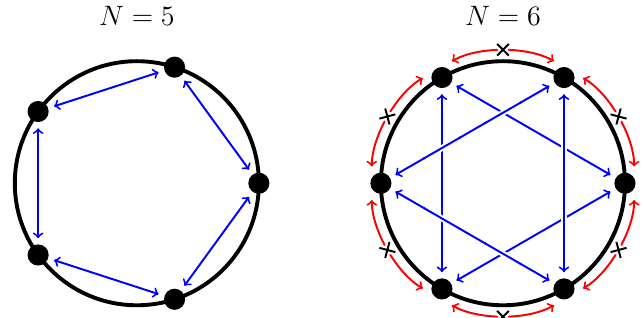
Figure 3: Examples of tunneling events between center-breaking minima on (cid:82) × S 1 with anti-periodic boundary conditions. The blue lines depict the minimal action tun- neling events without fermion zero modes. The red lines (marked with crosses) rep- resent tunneling events with robust fermion zero modes. When N = 5, the 5 − 1 = 4 zero modes found in the Abelian ansatz are all lifted in generic field configurations because ζ = 4 mod 2 = 0. As a result, the (cid:90) center symmetry is completely un- 5 broken. When N = 6, instantons associated with tunneling between neighboring minima carry ζ = 6 − 1 mod 2 = 1 robust fermion zero modes, and are forbidden. However, instantons associated with tunneling between next-to-nearest neighbors carry ζ = 2 ( 6 − 1 ) mod 2 = 0 robust zero modes, and are not forbidden. As a result, the (cid:90) subgroup of center symmetry remains 3